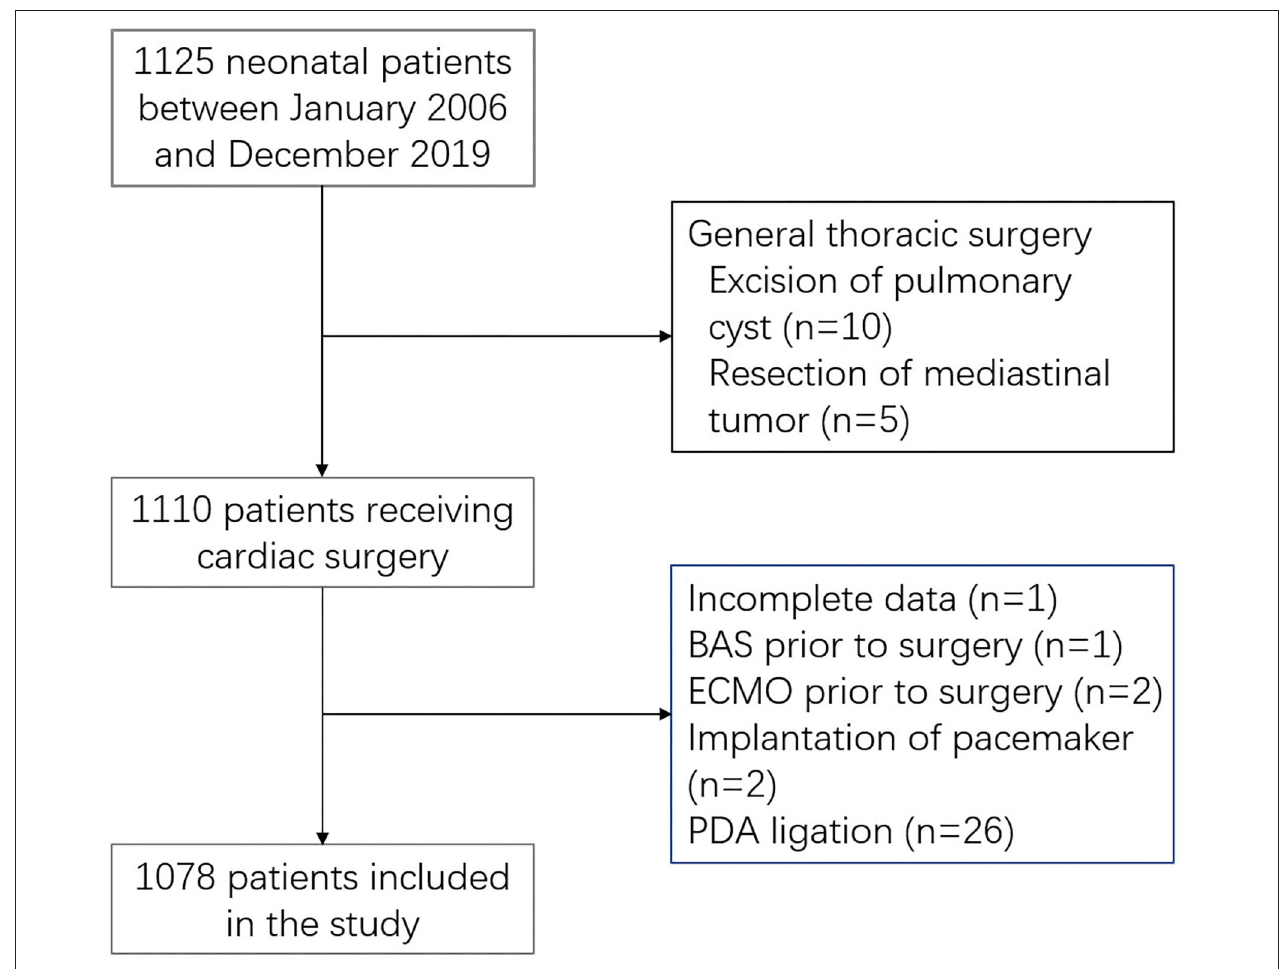
FIGURE 1 | Study population. BAS, balloon atrial septostomy; PDA, patent ductus arteriosus; ECMO, extracorporeal membrane